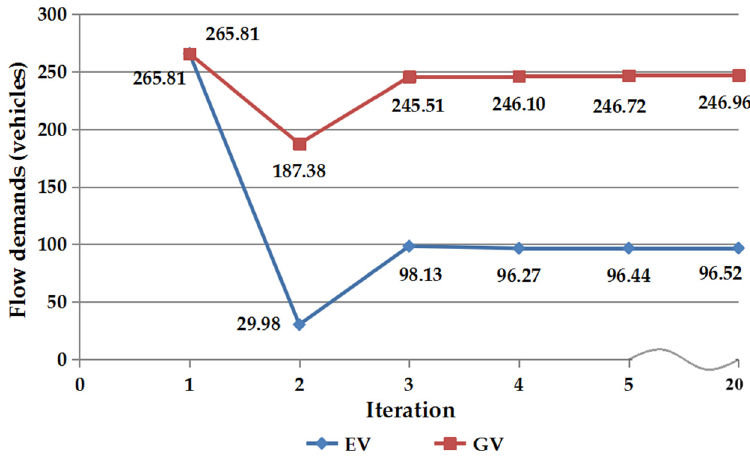
Figure 4. The flow demands of origin-destination (OD) pair (1,3).